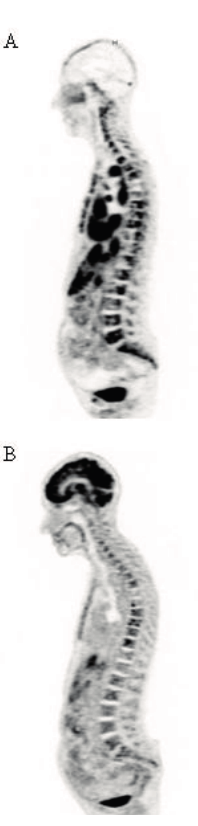
Figure 3. Positron emission tomography (PET) in a patient with a relapse of medullary thyroid carcinoma recorded after injection of the TF2 anti-carcino-embryonic antigen (CEA) bispecific antibody and the 68 Ga-IMP-288 peptide. Image shows a good detection of a bone lesion.